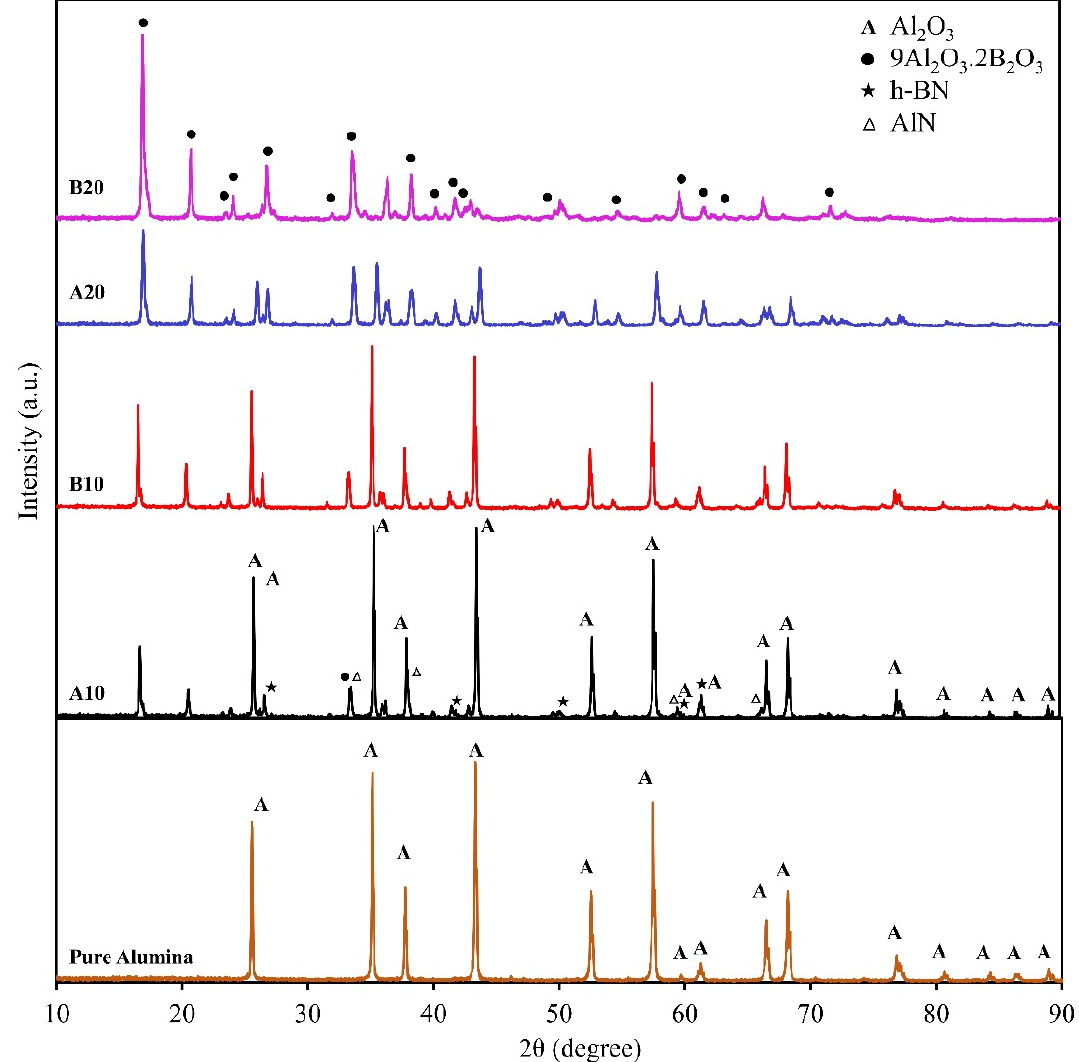
Figure 2. XRD spectrum of the pure alumina sample and the composites (A10, B10, A20, and B20).